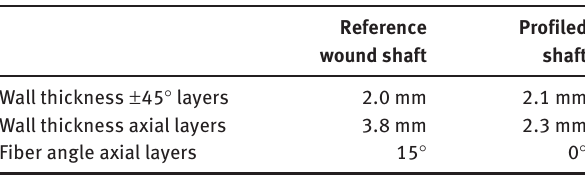
Table 7 Layup of the different shaft concepts (an outer diameter of 70 mm).